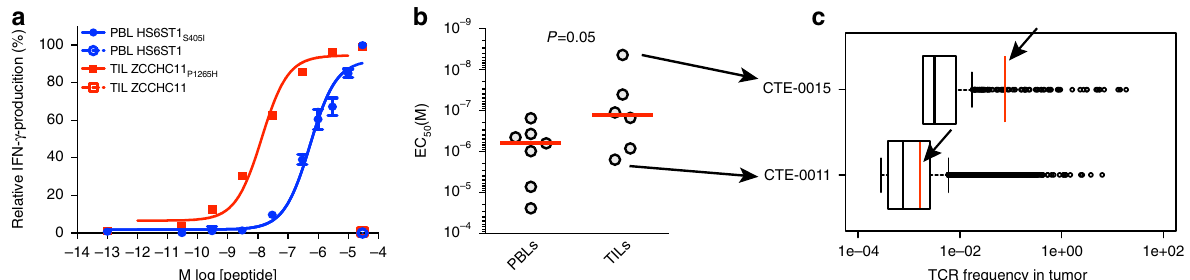
Fig. 5 Functional analyses of neo-epitope speci fi c PBLs and TILs. a Representative analyses of the functional avidity of neo-epitope speci fi c PBLs and TILs as assessed by IFN γ ELISpot. HS6ST1 S405I -speci fi c PBLs from patient CTE-0005 and ZCCHC11 P1265H -speci fi c TILs from patient CTE-0015 were stimulated with serial dilutions of cognate neo-epitopes or native (wt) peptides. Data show mean ± SEM of technical replicates. b Cumulative analysis (individual